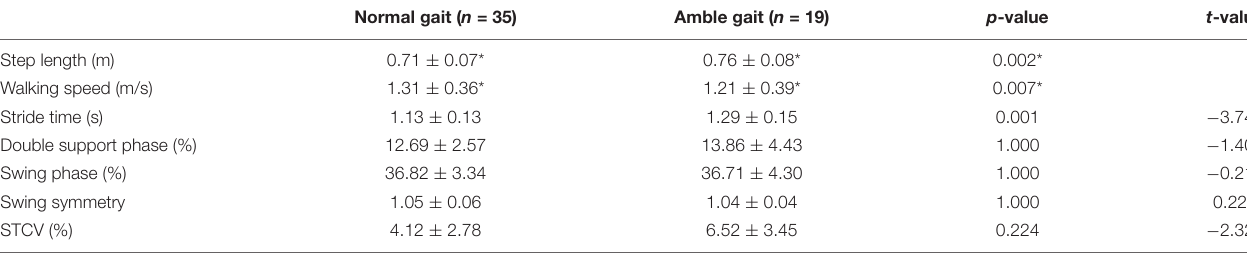
TABLE 1 | Spatiotemporal gait characteristics based on accelerometers and video recordings.